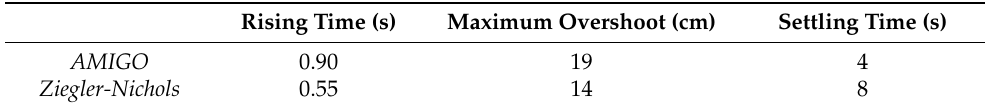
Table 9. The rising time, maximum overshoot, and settling time for the step response with an additional load of 4.7 g.